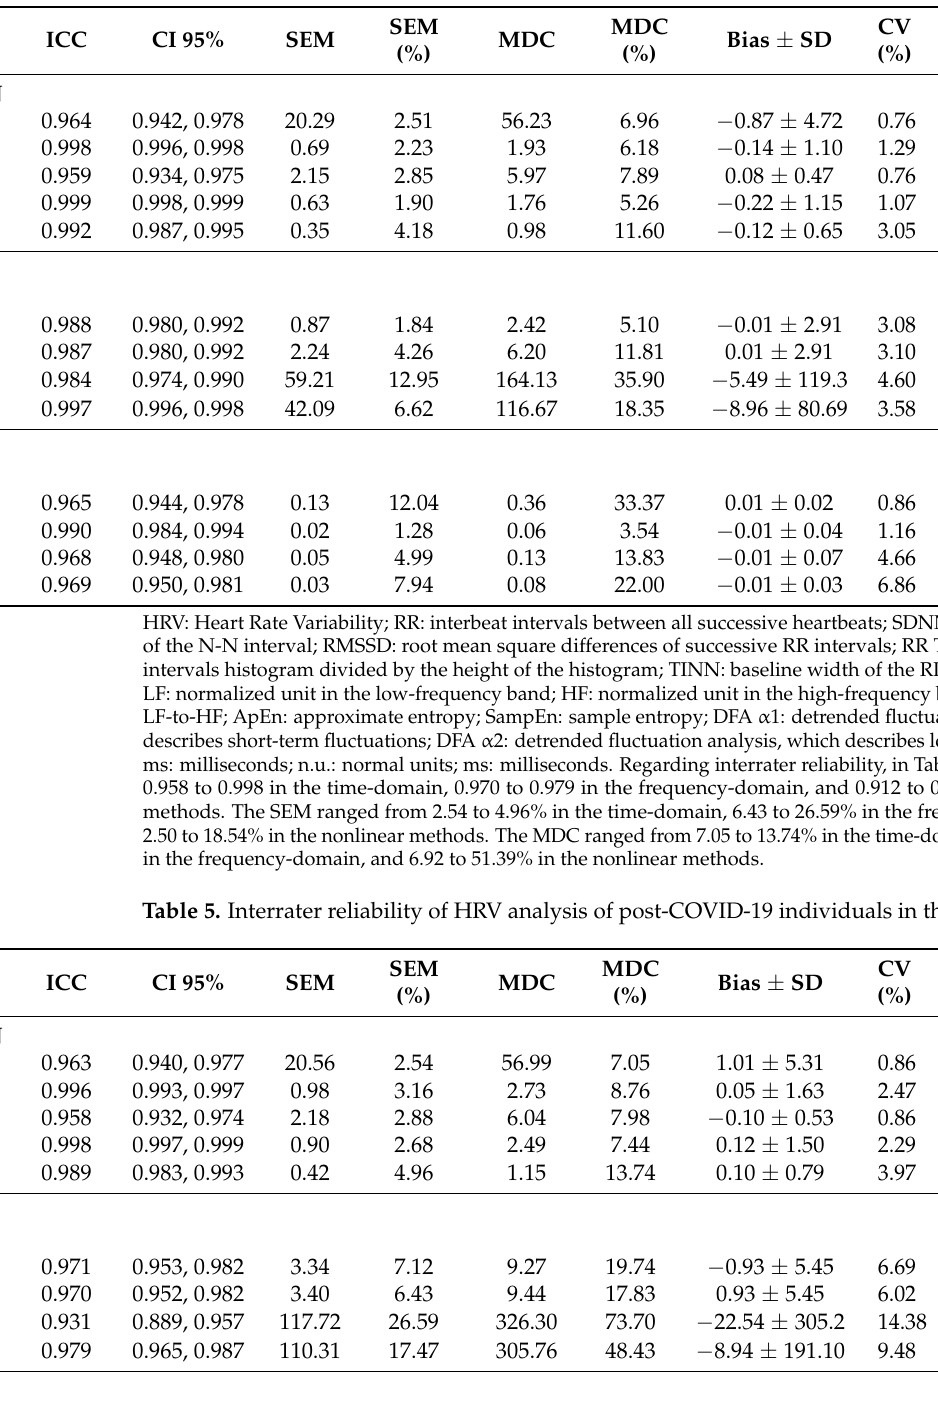
Table 4. Intrarater reliability of HRV analysis of post-COVID-19 individuals in the supine position (Researcher 02).